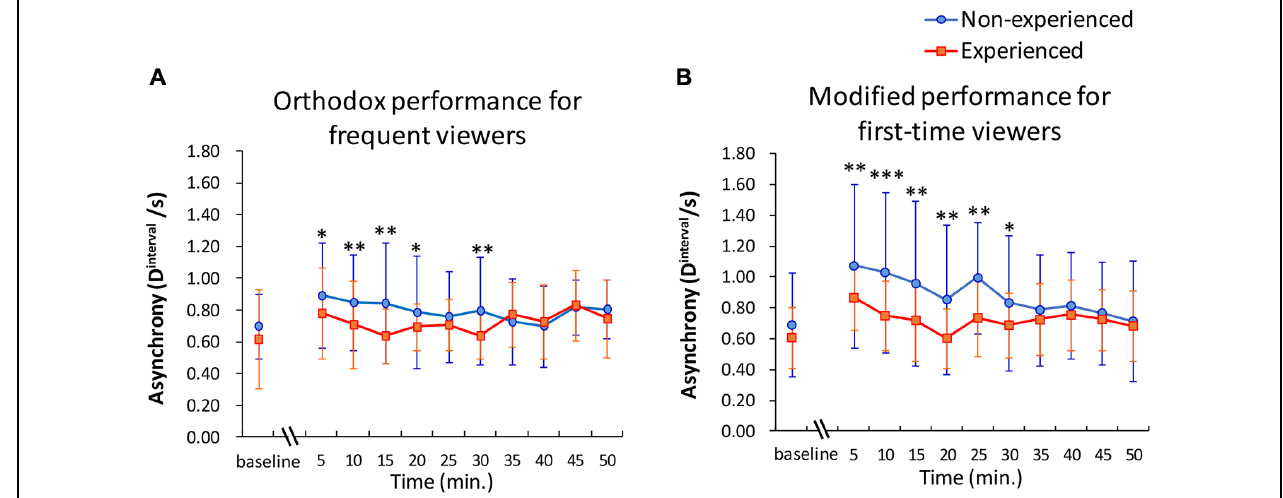
the SD. Asterisks and obelisks indicate the p -values of t -tests assuming unequal variance, which were performed in each scene between experienced audience